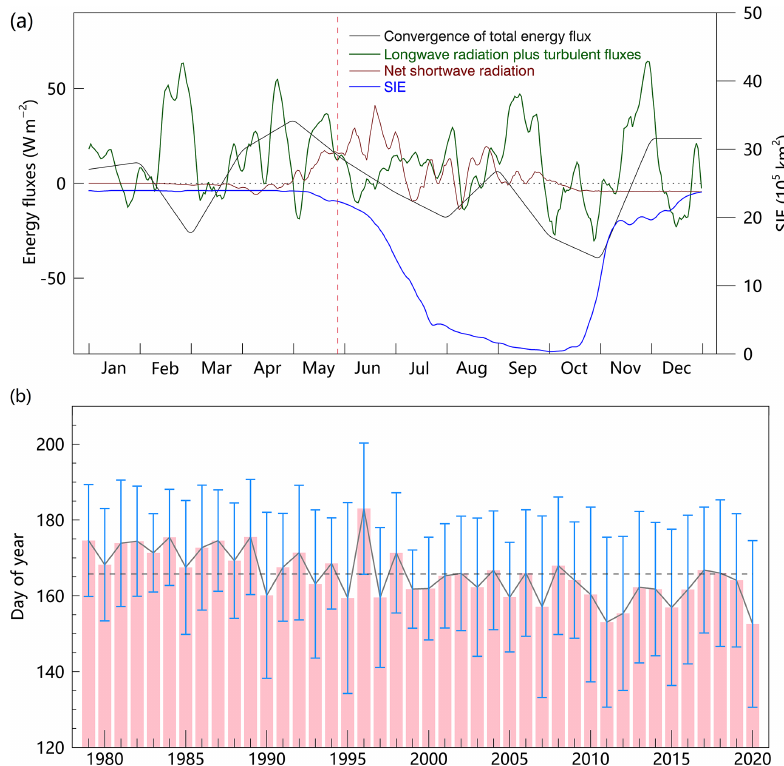
Figure 6. (a) Time series of SIE, the anomalies of atmospheric energy transport convergence, and surface energy fluxes over the study area (indicated by the purple polygon in Fig. 1) during 2020. The blue curve represents the SIE. The red line denotes the anomalies of net solar radiation. The green line corresponds to the anomalies of the sum of the downwelling thermal radiation and the turbulent (latent plus sensible) flux. The vertical dashed pink line denotes the average date of ice surface melt (28 May) in 2020. The retrieved values are averaged over the oceanic grids by applying a land mask. The anomalies are relative to the 1979–2020 climatology of the years. (b) Melt onset date in each year averaged over the study area during the period 1979–2020. The dashed gray line represents the mean melt date of these four decades. Error bars denote 1 standard